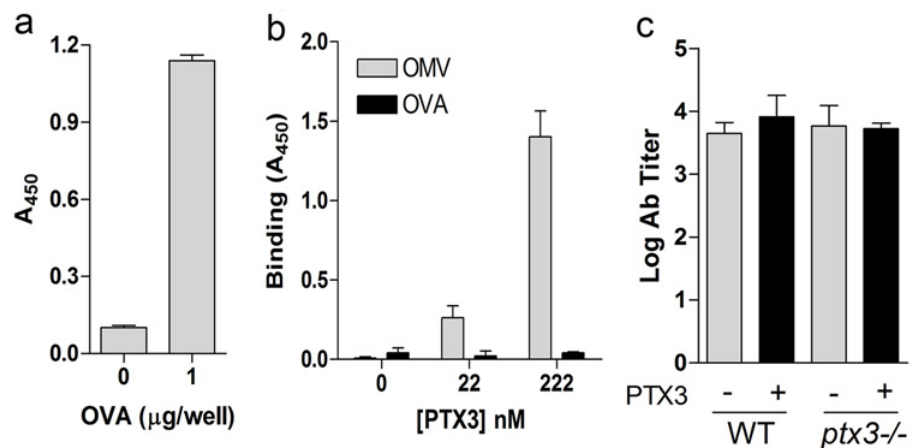
Fig 6. Antibody titer in mice immunized with OVA. Immune response to OVA was analyzed in WT and ptx3-/- mice. a) OVA was immobilized on plastic wells and presence of coated protein was confirmed by incubation with anti-OVA antibody. b) Binding to immobilized OVA or OMV as control (both at 1 μ g/well) was analysed using human bPTX3. Results are reported as A 450 (mean ± SD of triplicate wells). c) WT and ptx3-/- mice were immunized im with OVA (100 μ g/mice ± 2 μ g PTX3; each group n = 5) following the same setting used for OMV. Antibody titer was evaluated by ELISA.